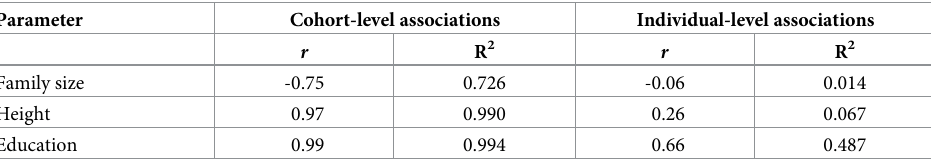
Table 1. Explained variance in mean intelligence test scores among the birth cohorts of 1940–1980.